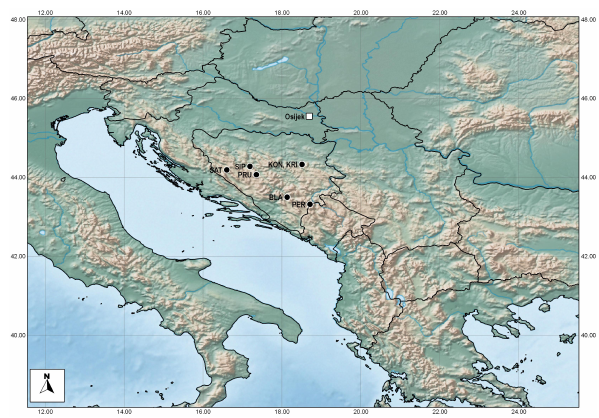
Fig. 1. Sampled sites, distributed along Dinaric mountains; ˇSator (SAT), ˇSipovo (SIP), Prusac (PRU), Blace (BLA), Peruˇcica (PER), Konjuh (KON) and Krivaja (KRI), with meteorological station Os-